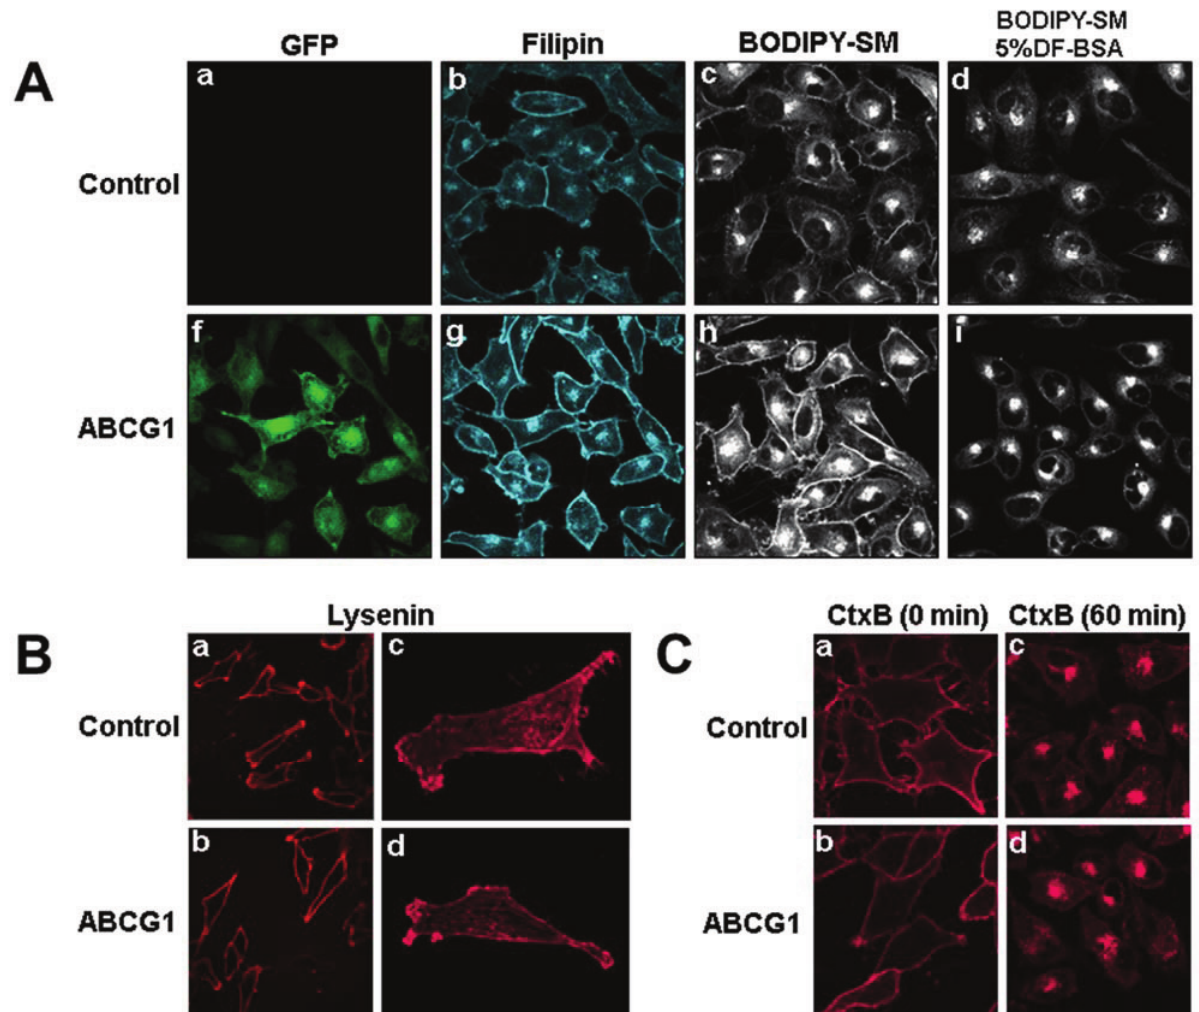
Figure 1. ( A ) ABCG1-GFP expression increases the amount of rapidly recycling, non-SM-associated cholesterol at the PM and LE. Cells were labeled with filipin, BODIPY-SM and Alexa594-CtxB, and imaged as described in “Experimental Section.” (a,f: GFP fluorescence; b,g: filipin; c,d,h,i; BODIPY-SM fluorescence). ( B ) ABCG1 expression does not alter SM-specific cytochemical lysenin staining at the PM. Note similar lysenin PM staining in single confocal image slices (a, b) as well as in 3D maximum projection images (c, d) of control and ABCG1 cells, respectively. ( C ) Cell surface GM 1 content and trafficking is not altered by ABCG1. The amount and distribution of fluorescent-tagged CtxB in living control (a, c) and ABCG1 cells (b, d) after labeling in the cold (a, b) and incubation for 60 min at 37 °C (c, d) is similar. Note that the imaging conditions in (a) and (f) were optimized for GFP fluorescence. The GFP fluorescence was exceeding low compared to the “green” BODIPY-SM signal and, the contribution of GFP to the “green” fluorescence in (c), (d), (h) and, (f) was essentially eliminated by adjusting the gain such that the GFP fluorescent signal from ABCG1 cells that were not labeled with BODIPY-SM was essentially eliminated (Supplemental Figure